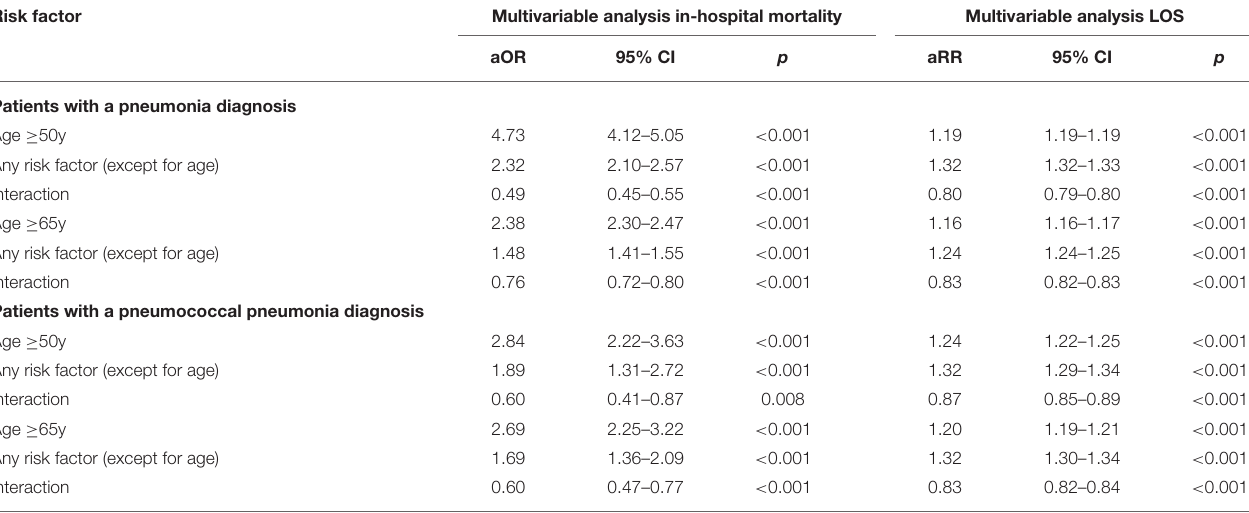
TABLE 3 | Effect of age and other risk factors on in-hospital mortality and length of stay in patients with a pneumonia diagnosis or a pneumococcal pneumonia diagnosis. Risk factor Multivariable analysis in-hospital mortality Multivariable analysis LOS